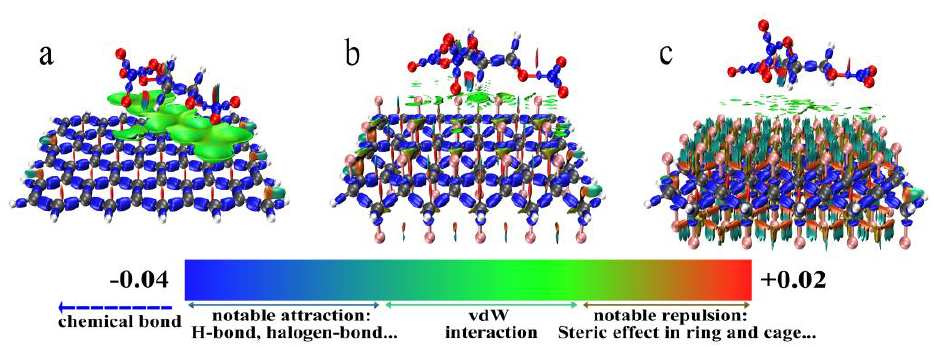
Figure 10. IRI maps with a color scale bar. ( a ) IRI map of graphene + NG. ( b ) IRI map of half-graphene + NG. ( c ) IRI map of whole graphene + NG.